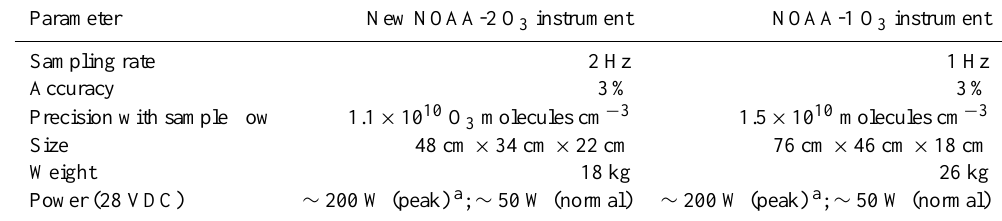
Table 1. Specifications of the NOAA O 3 instruments.